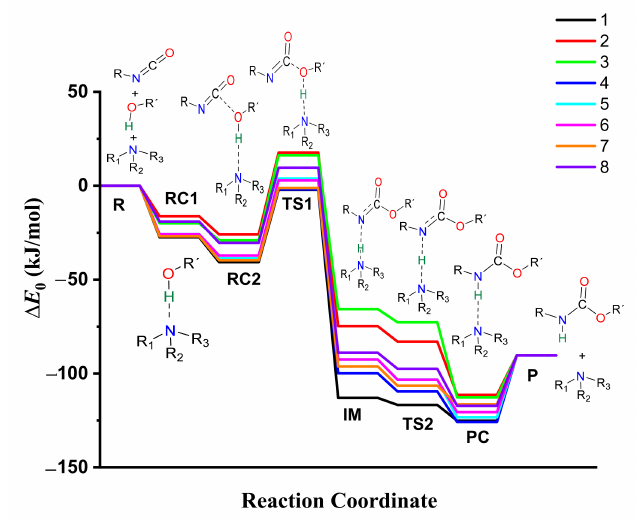
Figure 5. Energy profiles (zero-point corrected, ∆ E 0 ) of the catalyzed urethane formation reactions calculated with the G3MP2BHandHLYP composite method in acetonitrile, using the SMD implicit solvent model at 298.15 K and 1